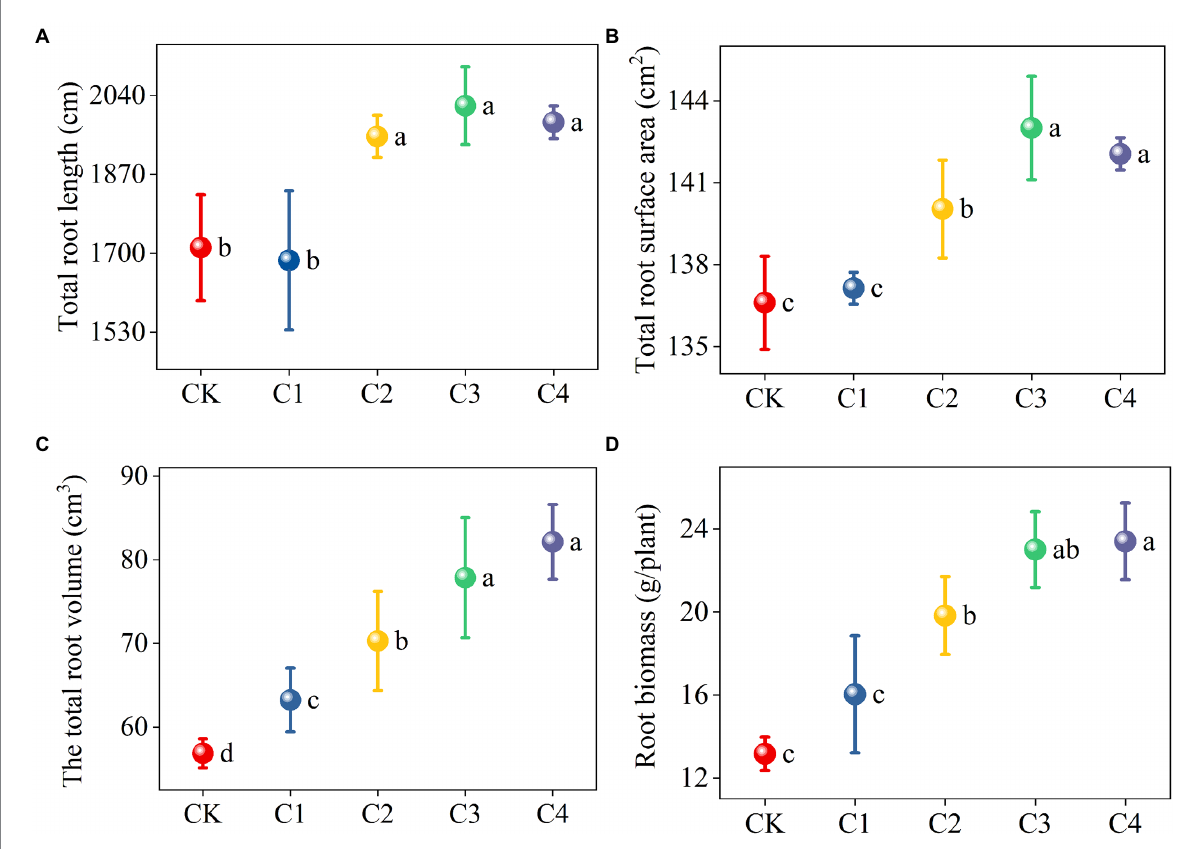
FIGURE 2 Effect of biochar addition on the architecture of maize roots. Different lowercase letters indicate significant differences under different levels of biochar application ( p < 0.05). (A) Effect of biochar addition on the total root length of maize. (B) Effect of biochar addition on the total root surface area of maize. (C) Effect of biochar addition on the total root volume of maize. (D) Effect of biochar addition on the root biomass of